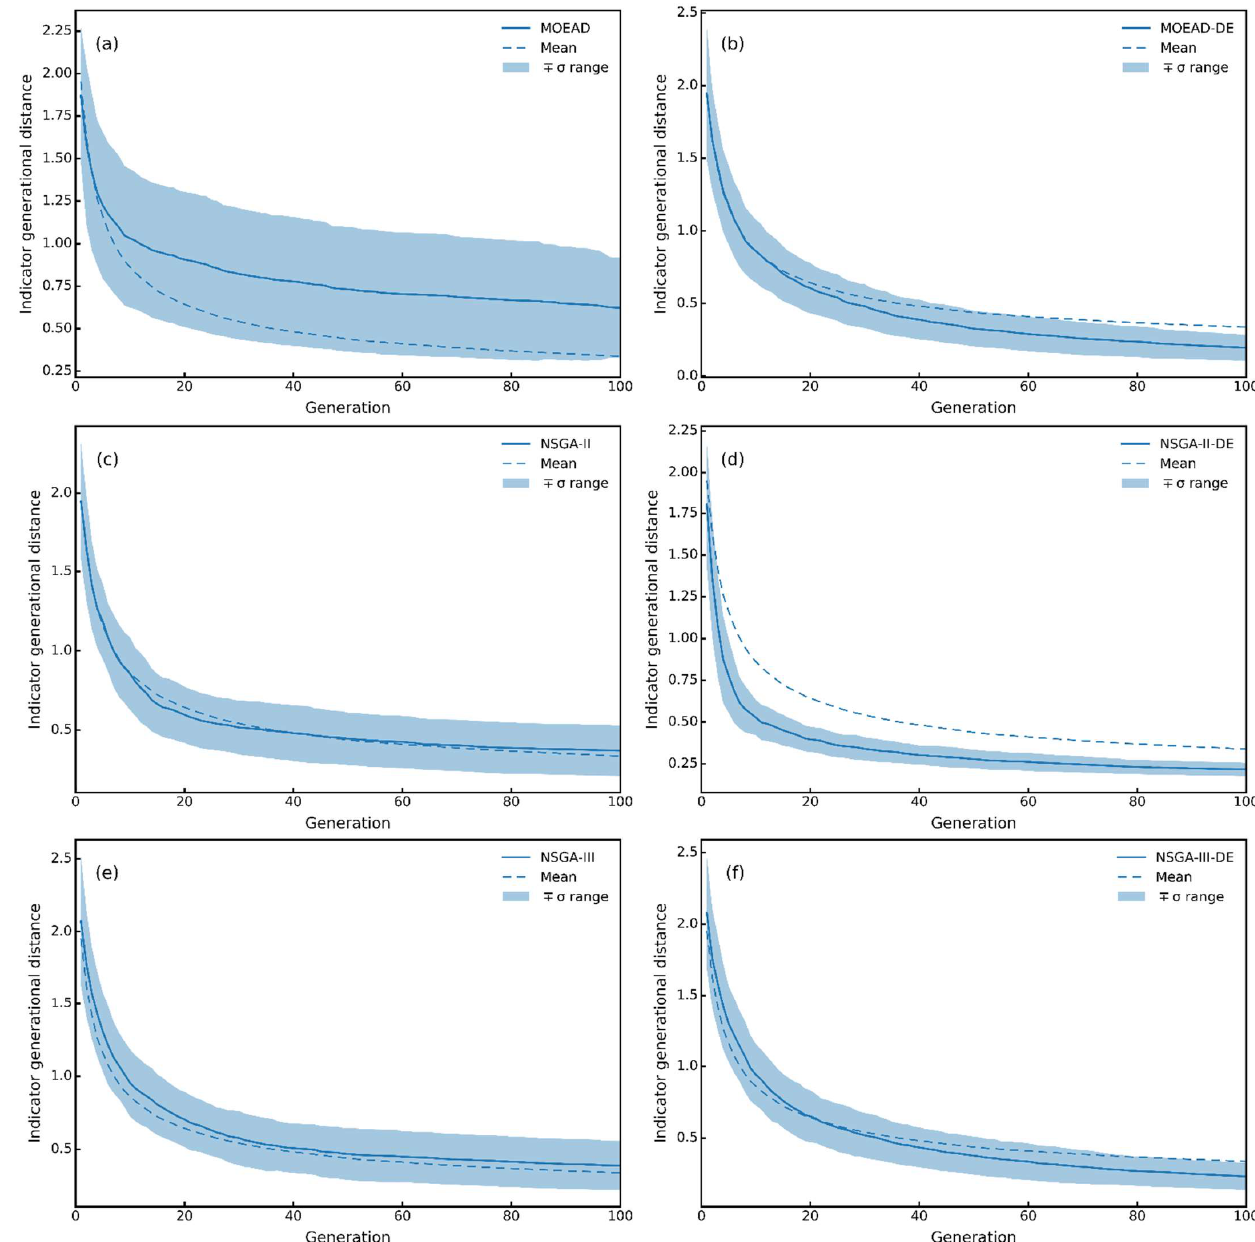
Figure 8. Indicator generational distance. ( a ) MOEAD; ( b ) MOEAD-DE; ( c ) NSGA-II; ( d ) NSGA-II-DE; ( e ) NSGA-III; ( f ) NSGA-III-DE. From Figure 9, the size of the marker indicates the probability of recurrence 100